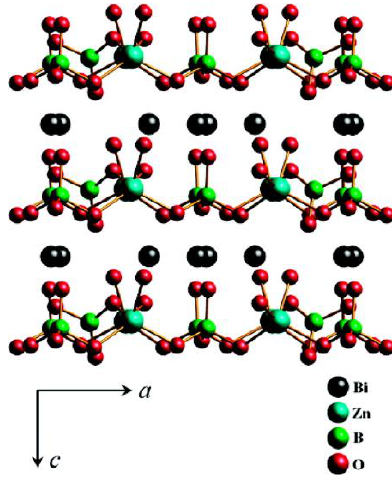
Figure 12. The crystal structure of Bi 2 ZnOB 2 O 6 viewed along b -axis. Reprinted with permission from Ref. [140], Copyright (2009) American Chemical Society.